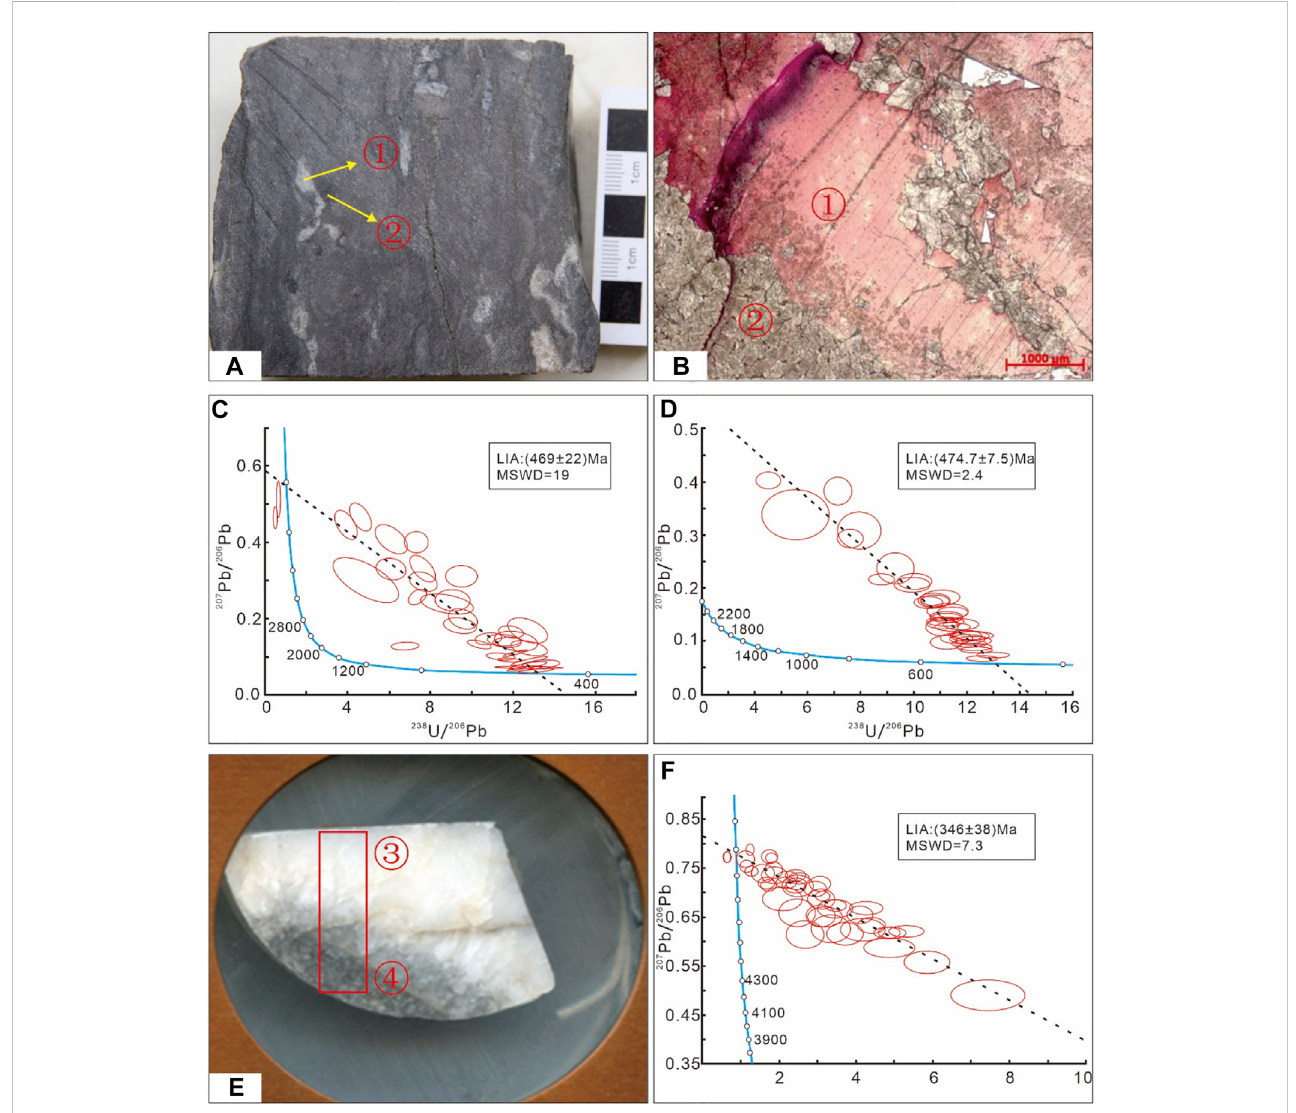
FIGURE 4 Characteristics of the Ordovician carbonate rock samples of the Tarim Basin (with marked sampling positions), and the U – Pb Concordia diagram. (A) . TwotexturalconstituentsoftheampletestedinDQ17: ① theintergrowth-crystallinecalciteinthepore-vugand ② the fi nedolomiteofthesurroundingrock; (B) . Sampling positionsfor thethin section of sample DQ17: ① the intergrowth-crystalline calcite in thepore-vug and ② the fi ne dolomite of thesurrounding rock; (C) . U – Pb isotope dating of the intergrowth-crystalline calcite in Sample DQ17; (D) . U – Pb isotope dating of the surrounding rock fi ne dolomite in Sample DQ17; (E) . Two tested textural constituents of Sample DQ11: ③ the coarse dolomite in the pore-vug and ④ the fi ne – medium dolomite in the surrounding rock; (F) . U – Pb isotope dating of the surrounding rock fi ne dolomite in Sample